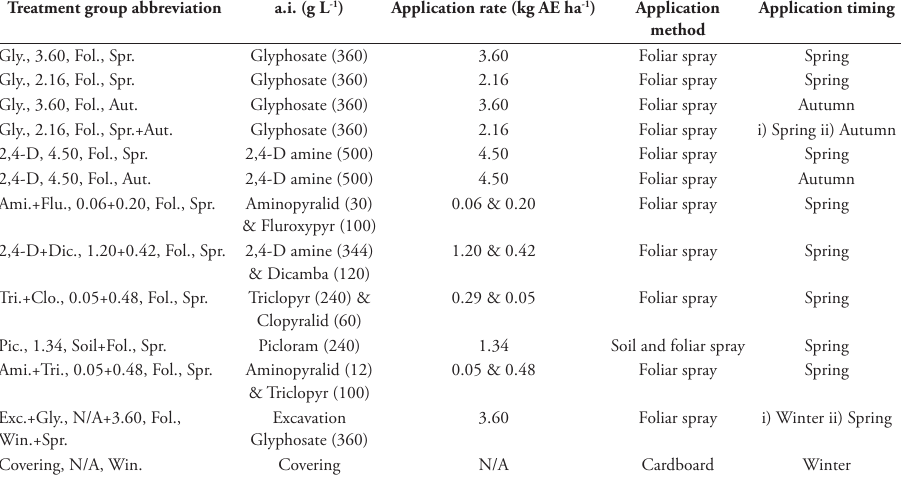
Table 1. Physiochemical Winter Heliotrope treatments, showing treatment group abbreviation, concen- tration of herbicide active ingredient (a.i.) within each product tested (g L -1 ), application rate measured in kilogrammes acid equivalent per hectare (kg AE ha -1 ), application method (e.g. foliar spray) and sea- sonal timing. Underlined herbicide active ingredients indicate product mix; italicised processes repre- sent physical components of integrated physiochemical control treatments; Roman numerals represent multi-seasonal application of physiochemical control treatments. Specific timing of seasonal application: autumn (stage 2) = September-November; winter (stage 3) = December-March; spring (stage 4) = April- June. Treatment group abbreviations are provided in the format: treatment, application rate, application method, season of application. Abbreviations used in the treatment groups are as follows: 2,4-D = 2,4-D amine; Ami. = aminopyralid; Clo. = clopyralid; Flu. = fluroxypyr; Gly. = glyphosate; Pic. = picloram; Tri. = triclopyr; Fol. = foliar application; Exc. = excavation; Spr. = spring; Aut. =